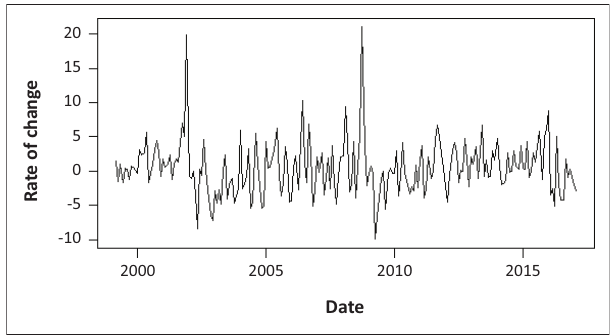
FIGURE 1: South Africa – Movement of the rate of change of monthly exchange